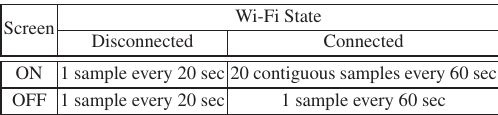
Table 1: PRiSM cellular signal sampling policy.